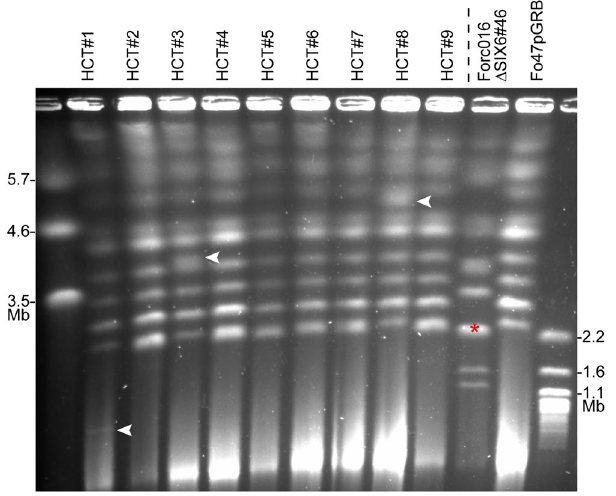
Figure 5. Nine strains derived from a HCT experiment between Forc016 ∆ SIX6 #46 and Fo47pGRB contain new chromosomes in the Fo47 background. Lanes 1–9 show the karyotype of HCT-derived strains, resembling that of Fo47pGRB (lane 11). Most of these strains have a double band at the size of chr RC (~2.5 Mb), marked in Forc016 ∆ SIX6 #46 with a red asterisk (lane 10). Strains #1, #3 and #8 do not have this double band, but instead have at least one novel chromosome that is not found in either parental strain (white arrowheads). The left and right lanes show the karyotypes of S . pombe and S . cerevisiae , respectively, applied as markers. This image is cropped, the original gel photograph can be found in Supplementary Fig. S12.